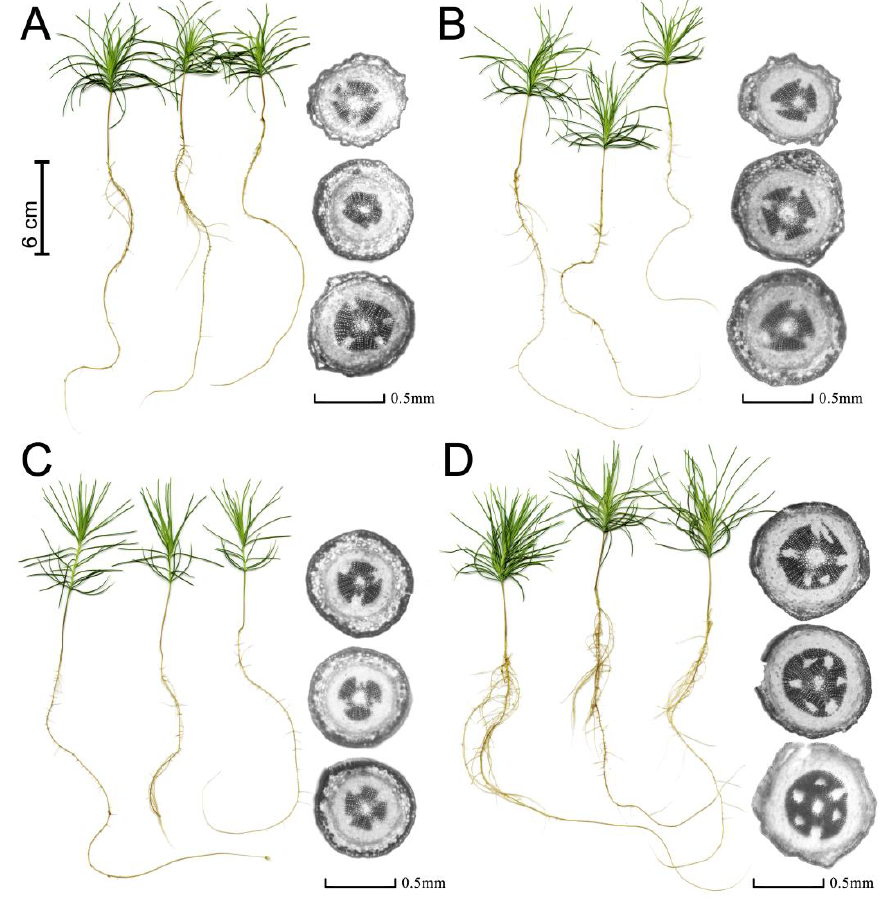
Figure 2. The morphological changes of P. sylvestris seedlings with dependence on light quality. WFL ( A ), BRL ( B ), BL ( C ), and RL ( D ). WFL ( A ), BRL ( B ), BL ( C ), and RL ( D